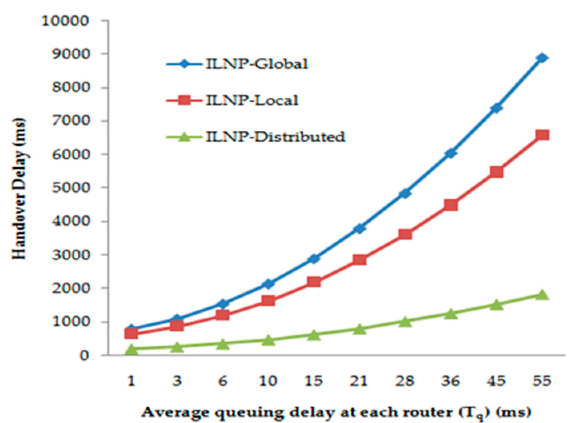
Figure 25. Impact of q on HOD.